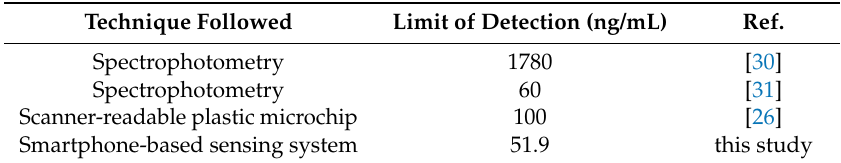
Table 1. Comparison between this study and other reports for detection of